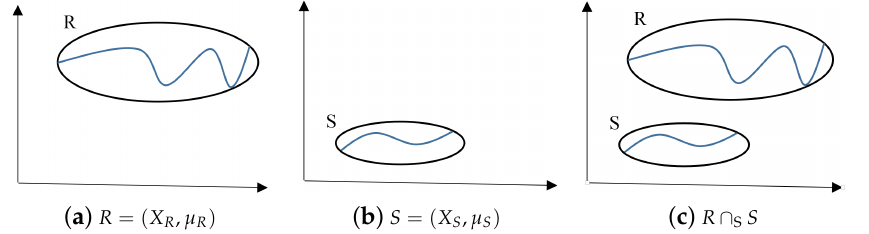
Figure 8. Example of a Soboci´nski intersection of functional partial fuzzy relations, which is not